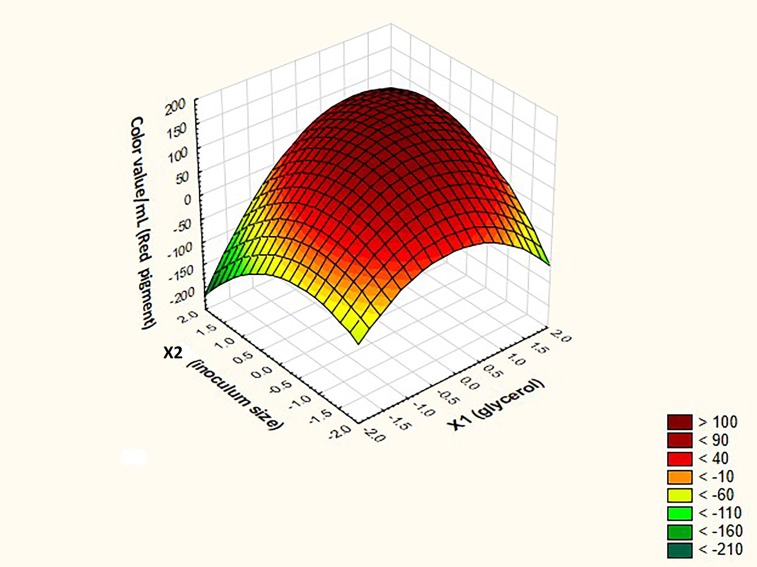
Three dimensional surface plots for the independent variables glycerol and inoculum size in relation to red monascus pigments production.